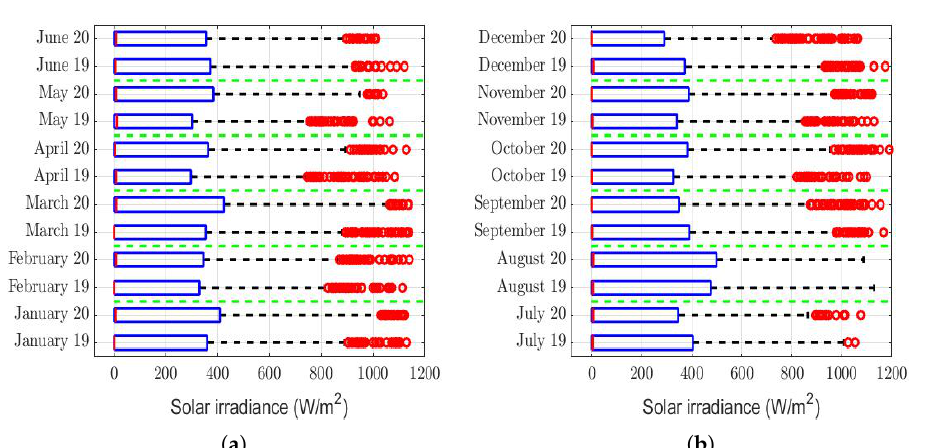
Figure 7. Box plot of the solar irradiance (W/m 2 ): 2019 vs. 2020. The red circles represent the outliers.